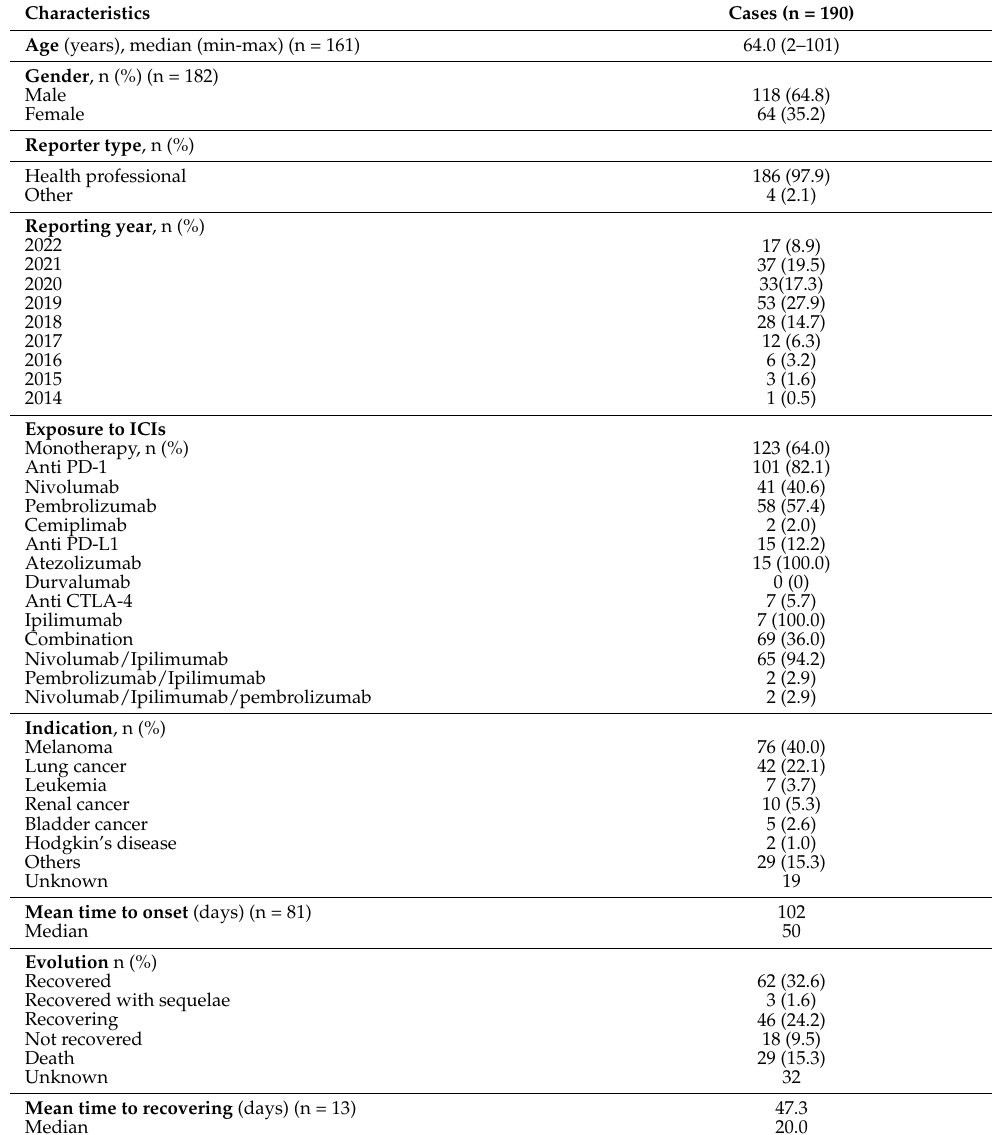
Table 1. Characteristics of ICI-induced HLH cases reported in VigiBase ® (n = 177) and in the literature (n =